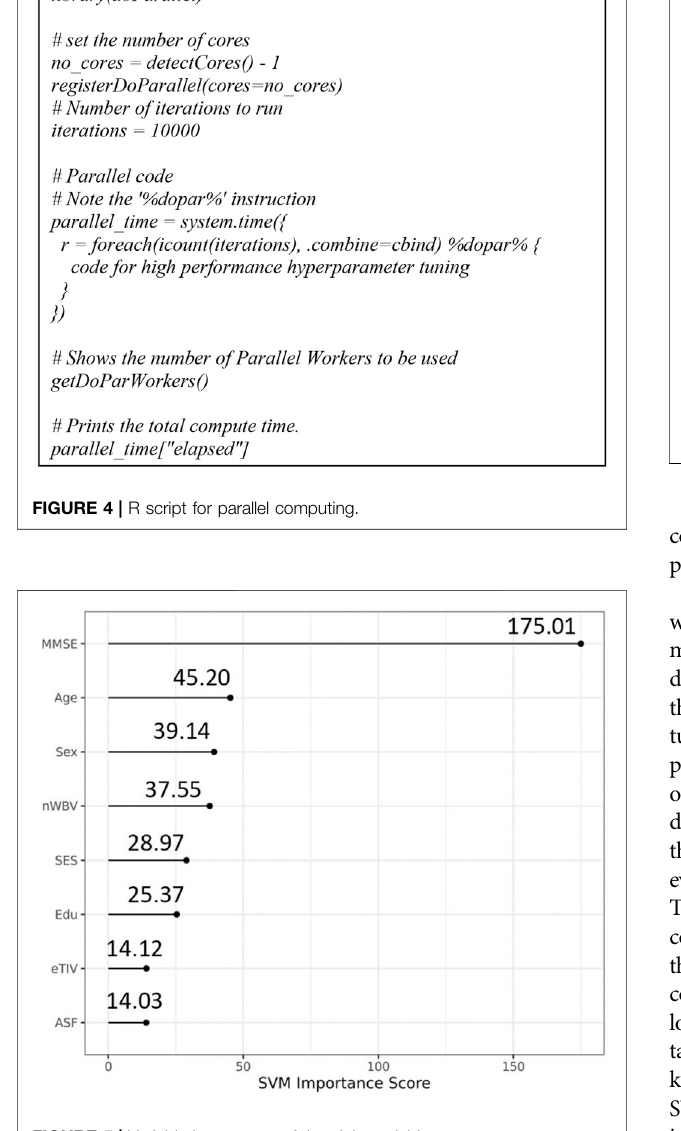
FIGURE 5 | Variable importance of the eight variables.